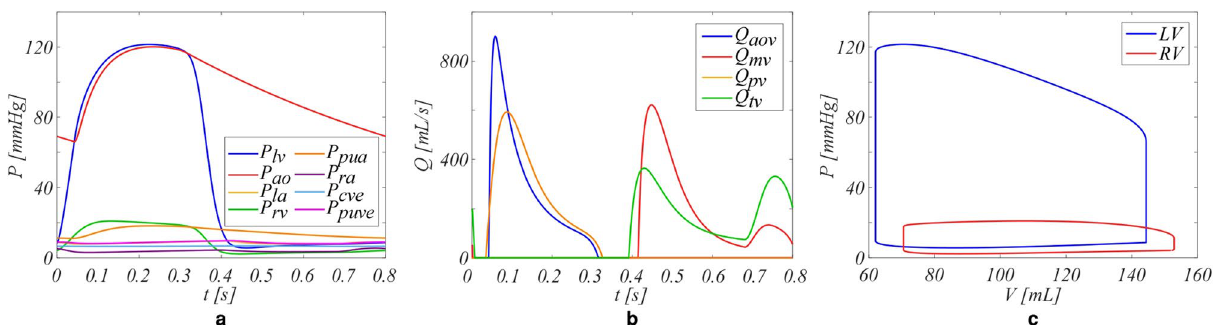
Figure 2. Hemodynamic waveforms of the healthy condition. ( a ) Pressures, ( b ) flows, and ( c ) pressure–volume (PV) loops. Subscripts: lv left ventricle, Ao aortic and arterial vessels, sr systemic vascular bed, rv right ventricle, PuA pulmonary arteries, pr pulmonary vascular bed, Aov aortic valve, Mv mitral valve, Pv pulmonary valve, Tv tricuspid valve. The LV presents with flow peaks which are higher than the RV, exhibiting an LV pressure almost 6 times greater than the RV estimated one, both having a stroke volume of about 80